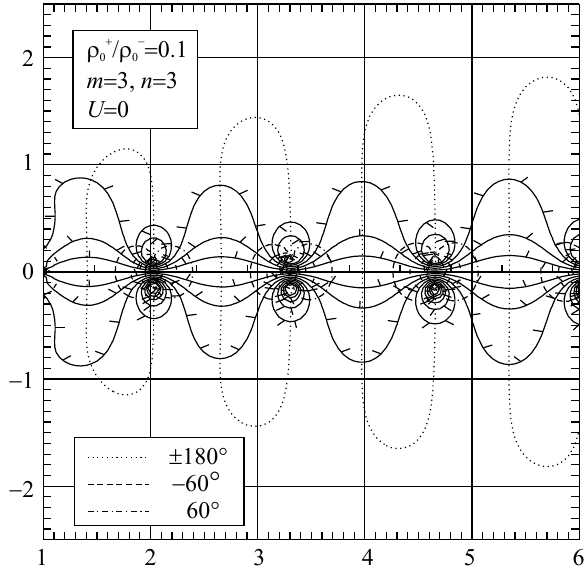
Fig. 7. Reflection coefficient contours